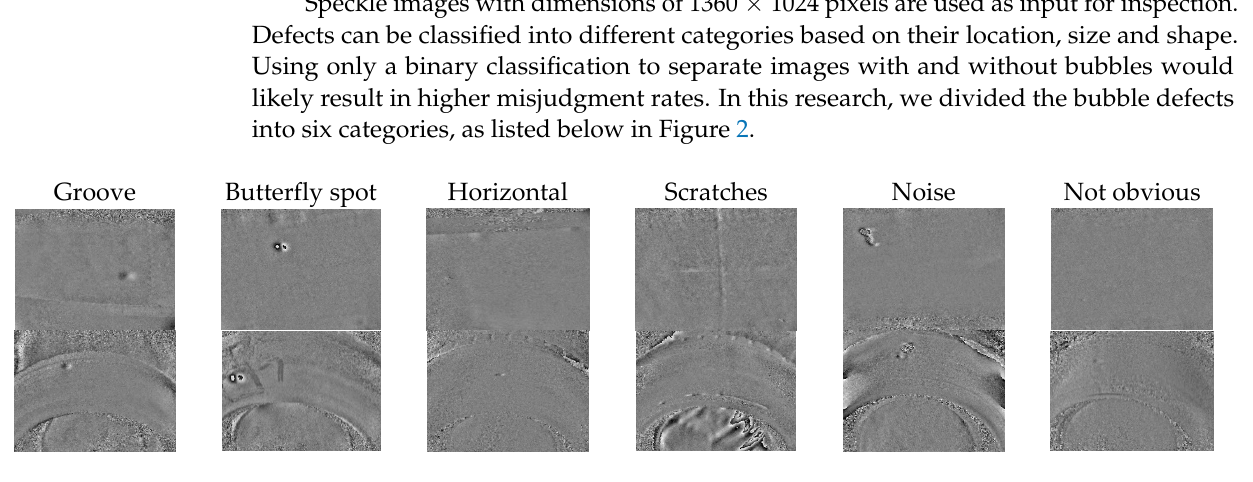
Figure 2. Six types of bubble images ( a ) Tire tread defects and ( b ) Tire sidewall defects.